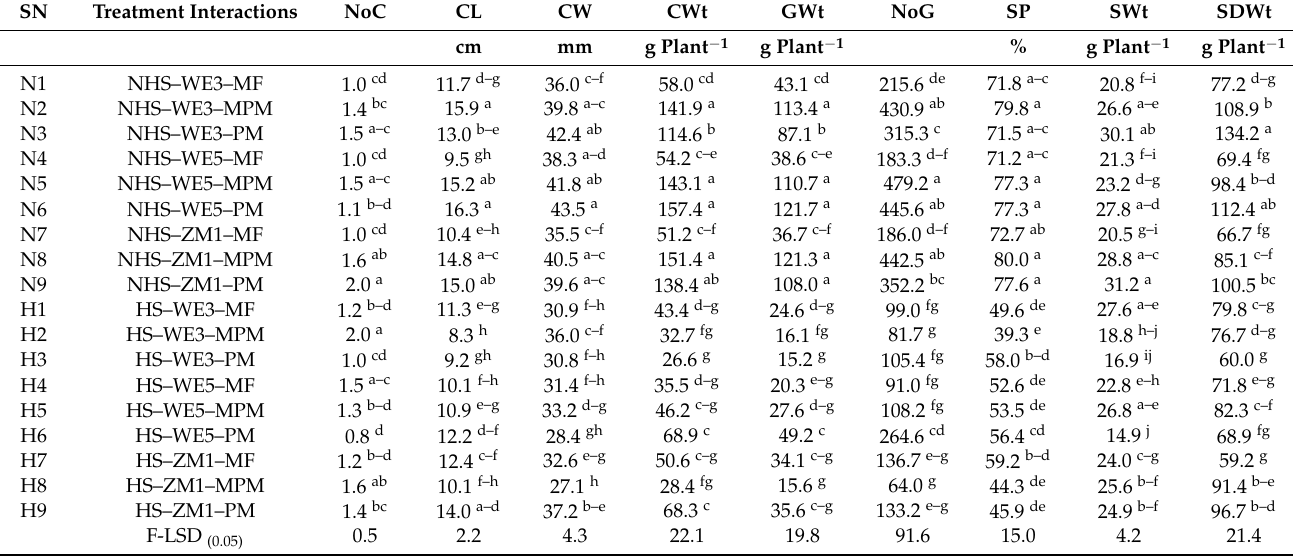
Table 3. Interaction of heat stress, maize variety, and soil amendment on the maize yield attributes.